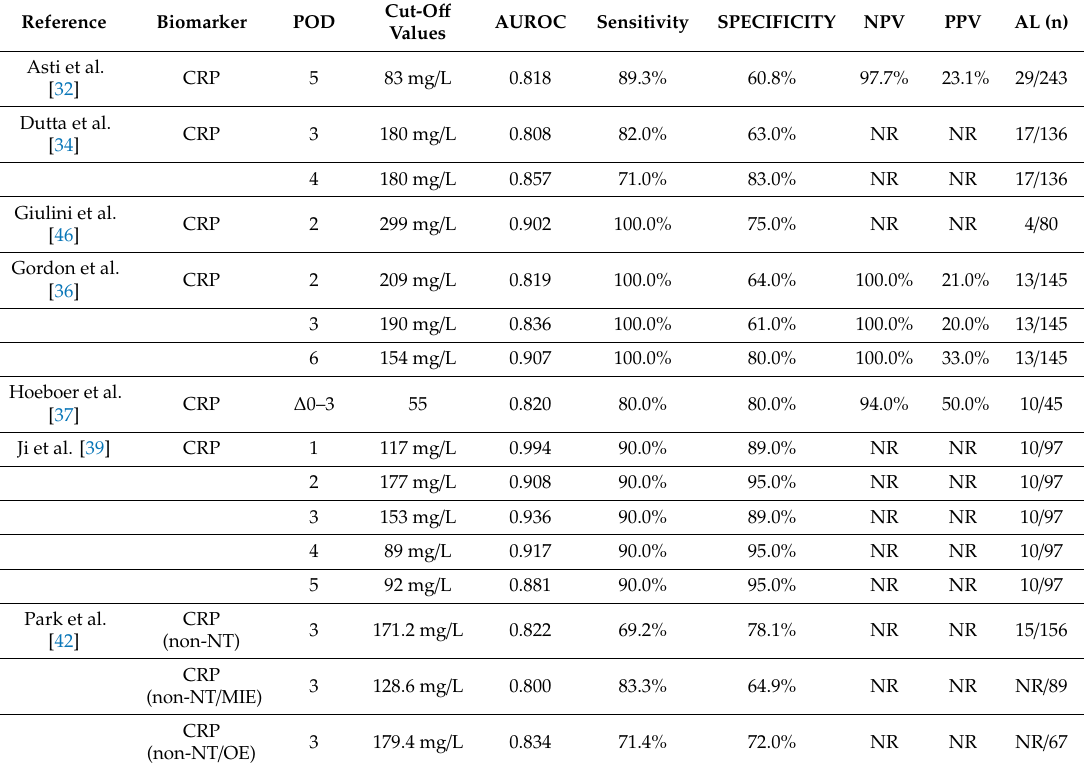
Table 3. Summary of very good diagnostic accuracy of CRP